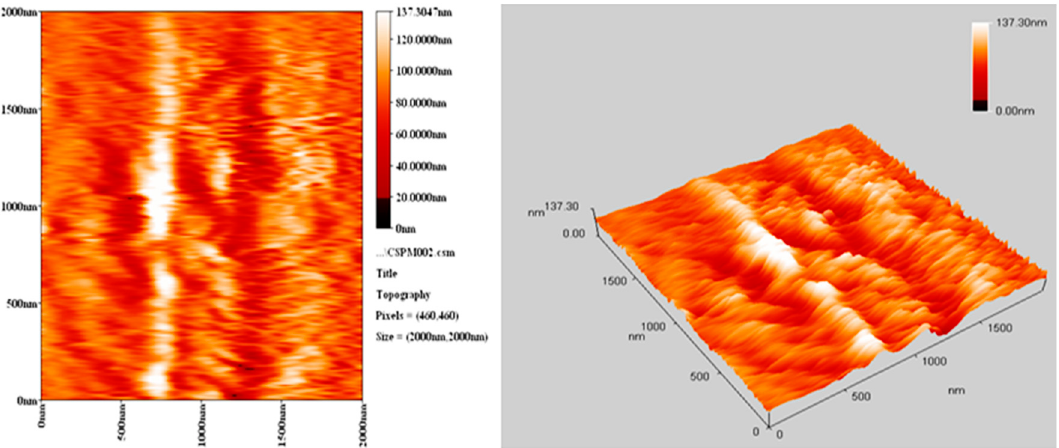
Figure 10. AFM images for PVC film (control) after irradiation (300 h).